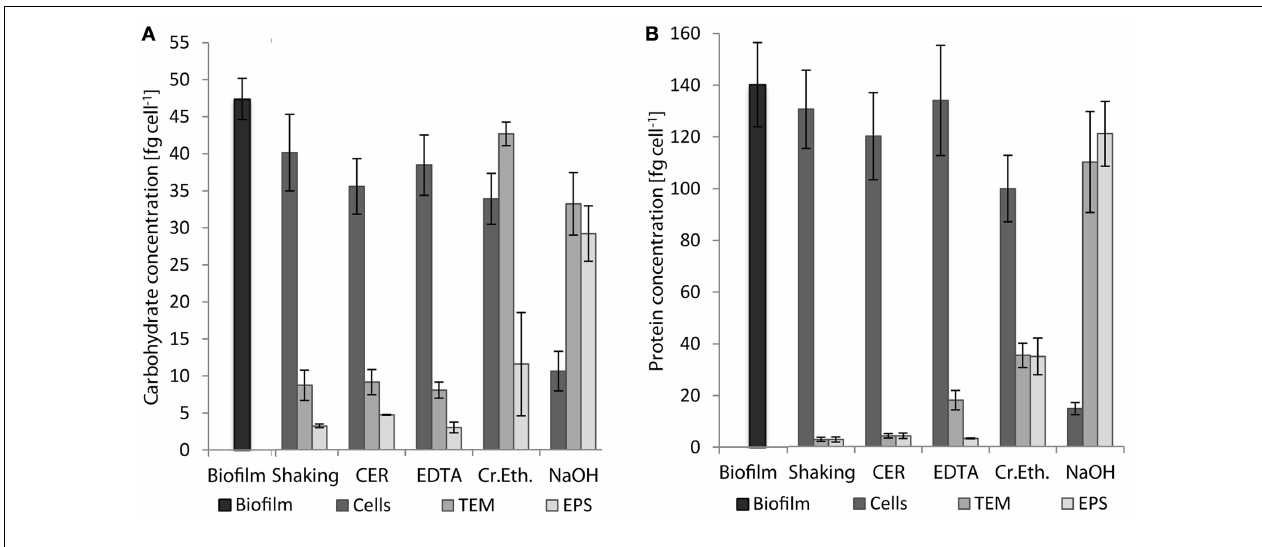
FIGURE 1 | Concentrations of carbohydrates (A) and proteins (B) in whole biofilms of S. acidocaldarius and different biofilm fractions after EPS extraction with shaking, CER, crown ether (Cr.Eth.), EDTA,